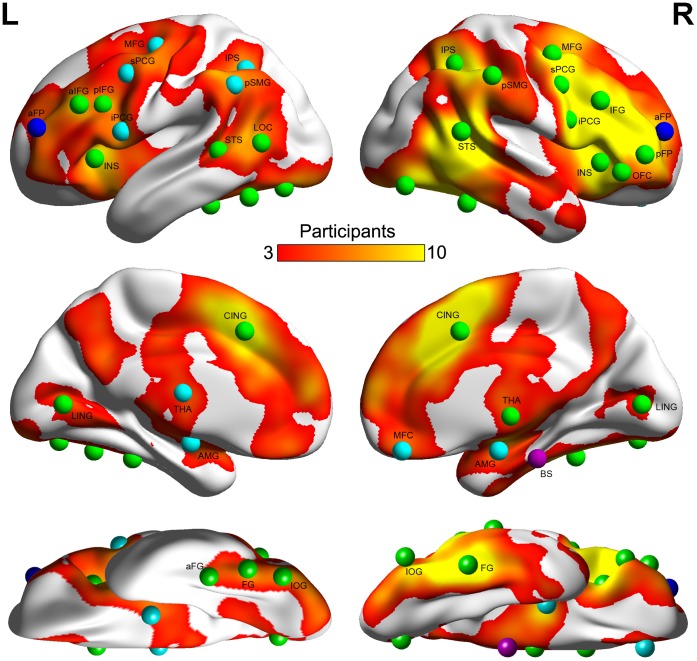
Probabilistic map and peak locations of group-level ROIs overlaid on mean MNI152 brain surface.The probabilistic map was created by overlaying participants’ binarized activation maps with the contrast of faces versus objects. Color bar indicates the number of participants who showed face-selective activation. Spheres indicate the peak locations of thirty-seven group-level ROIs. ROIs that failed to meet the criteria of cross-subject reliability, cross-session reliability and face selectivity were colored with magenta, blue and cyan, respectively. ROIs that met all criteria were colored with green. L: left hemisphere; R: right hemisphere.